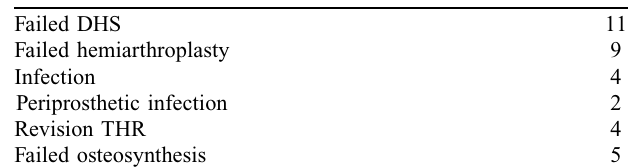
Table 2. Revision surgery 35 cases.